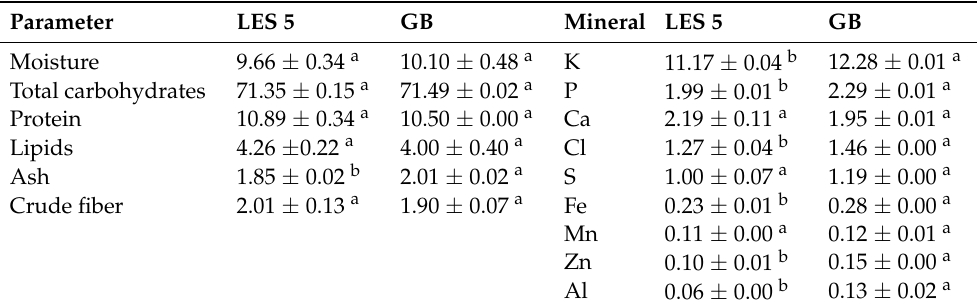
Table 1. Proximate composition (%) dry weight and mineral composition (mg/g) of sorghum grains of two